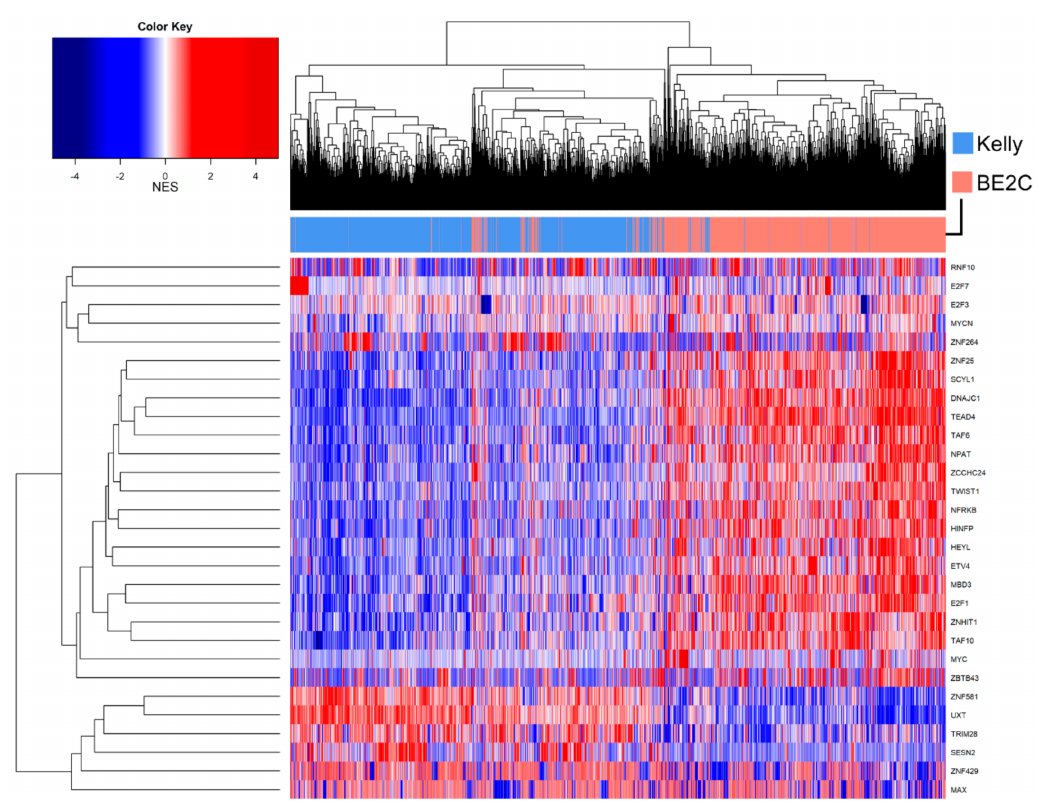
Figure 7. Single-cell master regulator analysis, calculated using the TARGET-derived network [22]. Single-cell scores are reported as NES compared to the mean value of the entire dataset. Cell line is reported on top as salmon (BE2C cells) and cornflower blue (Kelly cells). Cells are clustered using the R hclust algorithm based on Euclidean distance with default